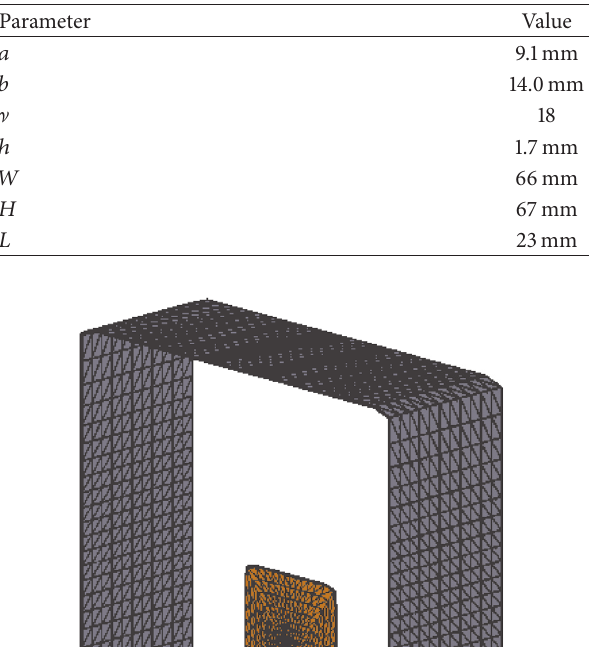
Table 1: Optimal set of parameters.